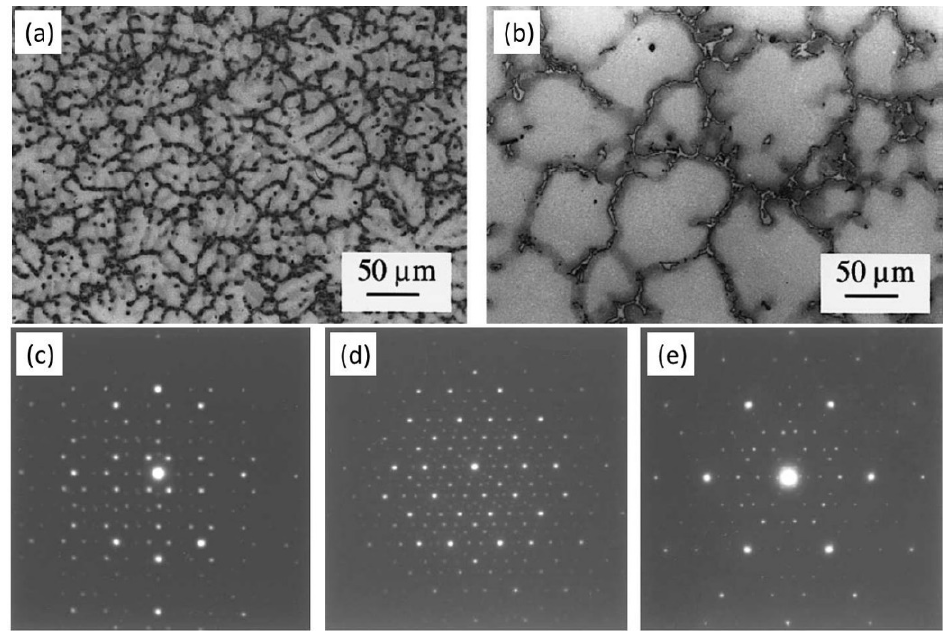
Figure 15. ( a , b ) OM images and ( c – e ) SAED patterns of intermetallic phases in the HPDC ZA85 alloy [157].